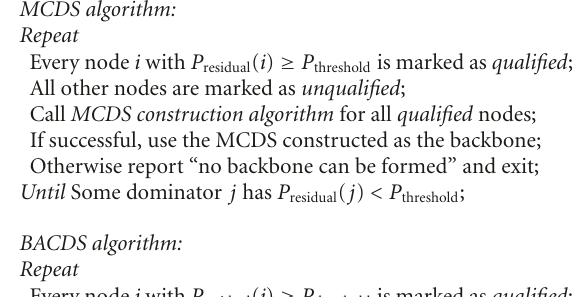
Table 1: The maximum size of the recovery table ( β = 0 . 4).